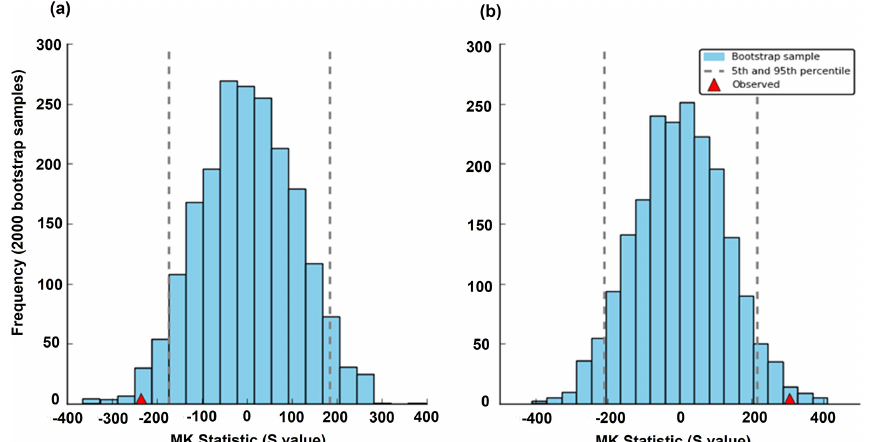
Figure 8. Examples of histograms for two stations representing the frequency distribution of the MK statistic ( S ) obtained from 2000 samples of moving block bootstrap iterations; red triangles are observed values, and dotted lines show the 5th and 95th percentiles for (a) a decreasing trend and (b) an increasing trend in the Tasmania (III) and Carpentaria Coast (IX) divisions